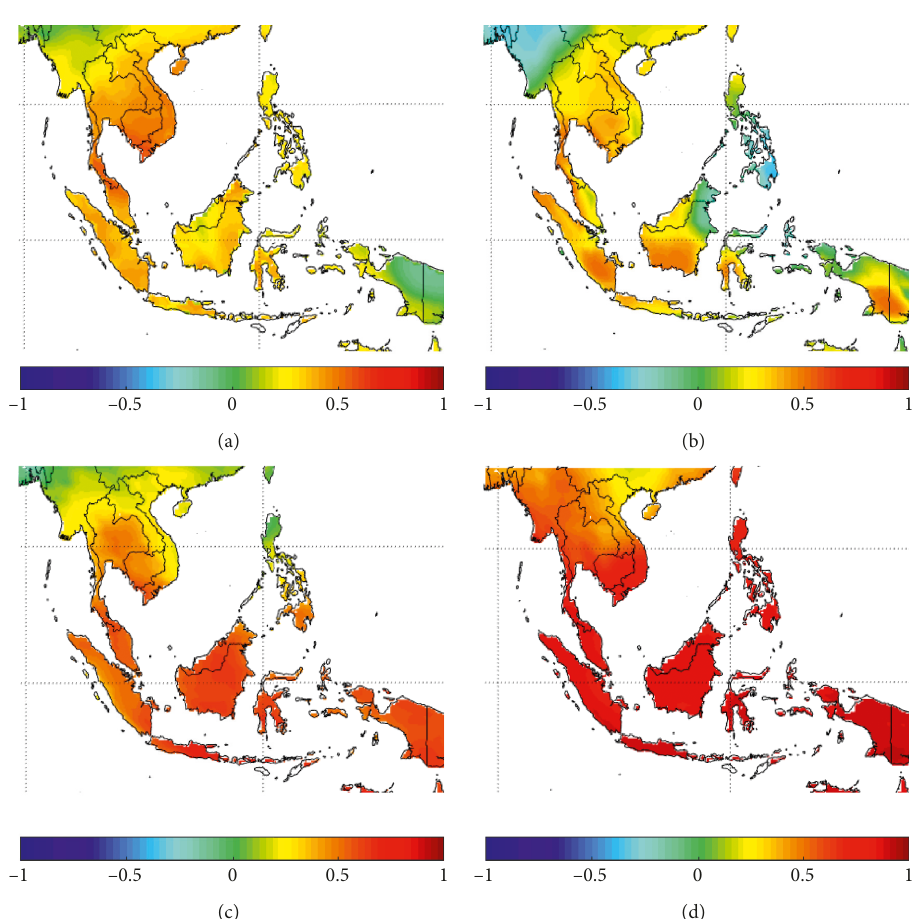
Figure 9: Correlation coefficients of cold-season temperature and Niño3.4 index (ENSO-Ts) for years 1901–1999 of (a) observations, (b) CNRM-CM5-2, (c) 6-GCM-Ensemble, and (d)